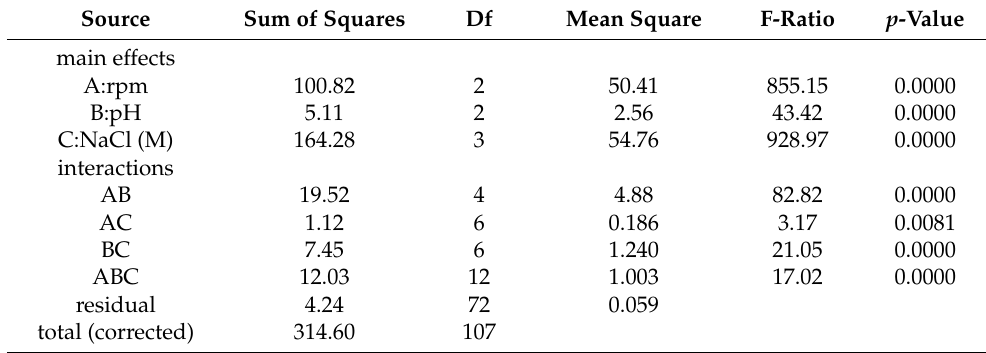
Table 1. Analysis of variance for N-AcG (mg/g)—type III sums of squares.